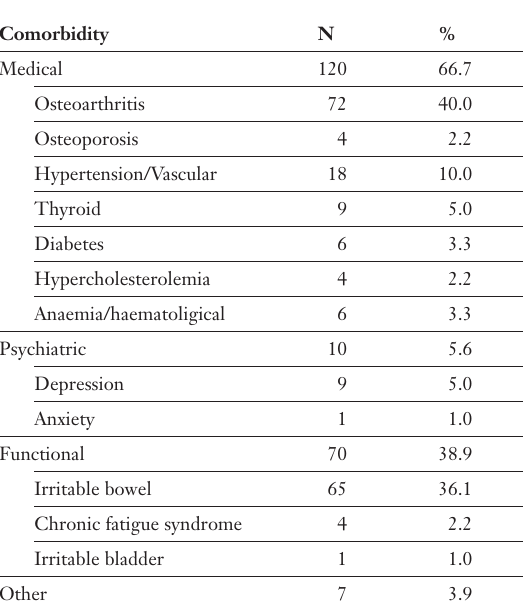
Baseline comorbidity in the sample of women (n = 180) with